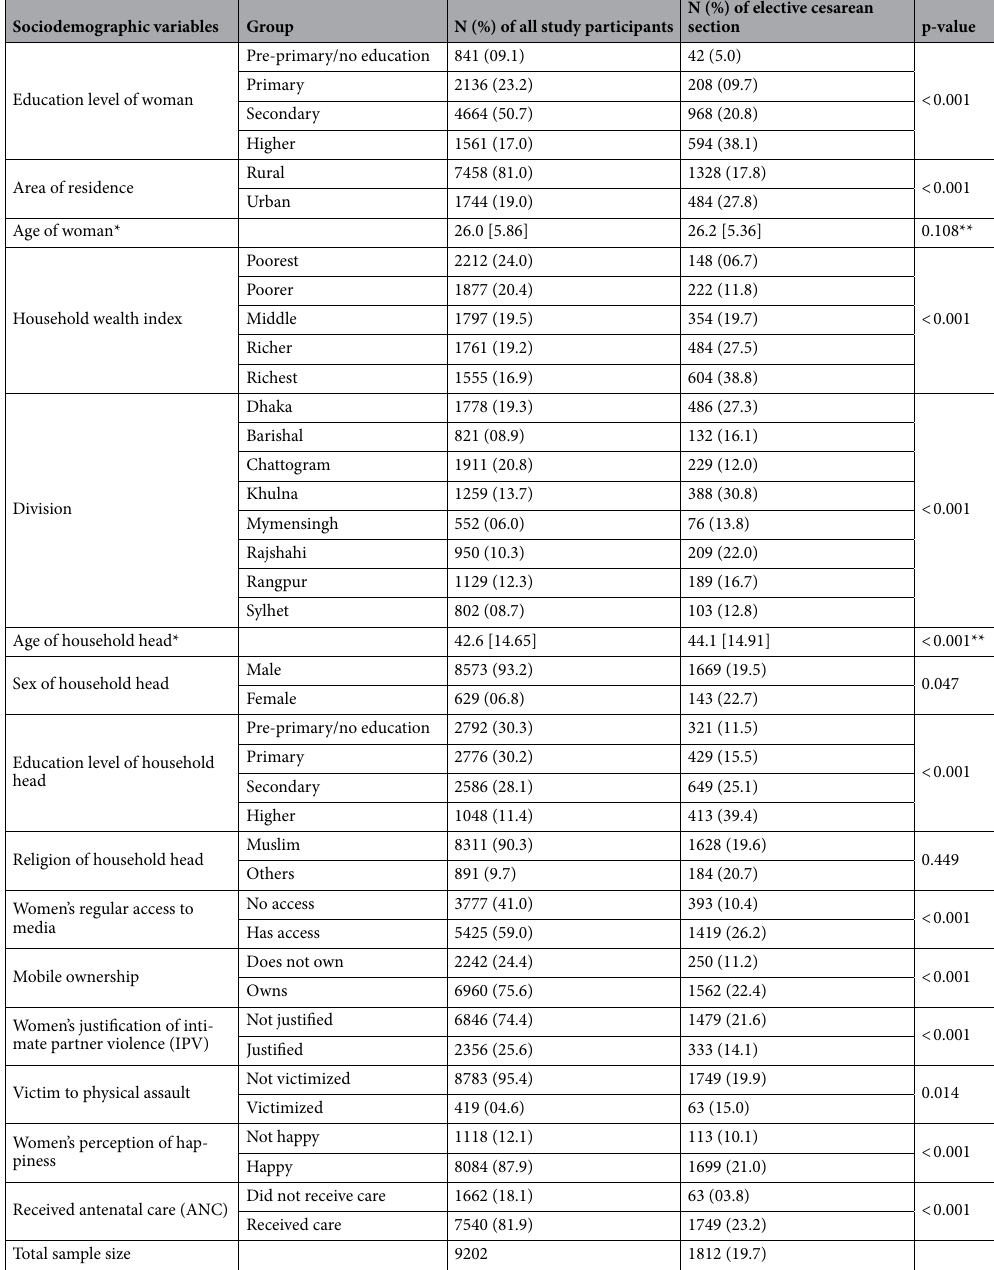
Table 1. The distribution of elective cesarean section (binary) by sociodemographic variables (categorical and continuous) among women who gave birth in the last two years from MICS 2019. *Mean [standard deviation]. **p-value from